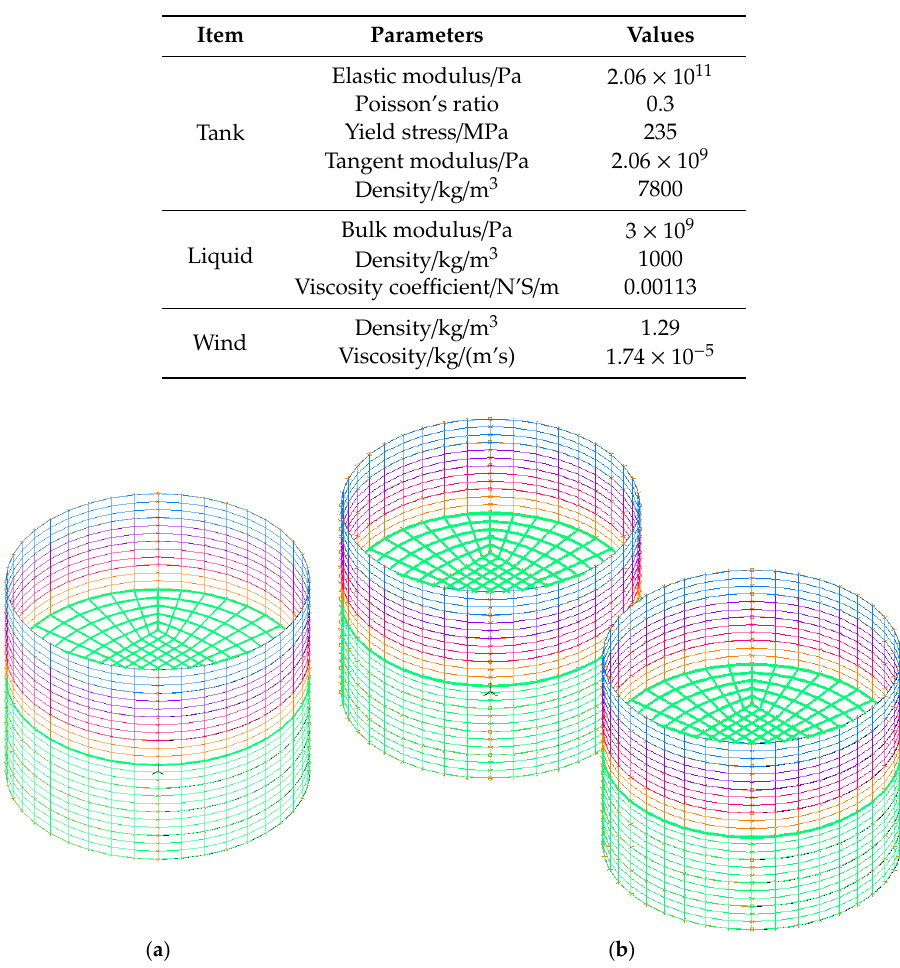
Figure 4. Calculation model of shell–liquid interaction. ( a ) Single tank. ( b ) Double tank.